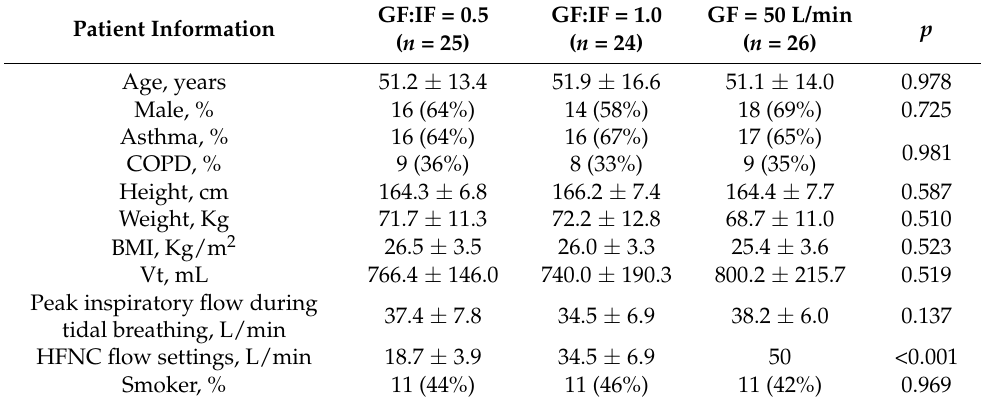
Table 1. Demographic information of patients in the three